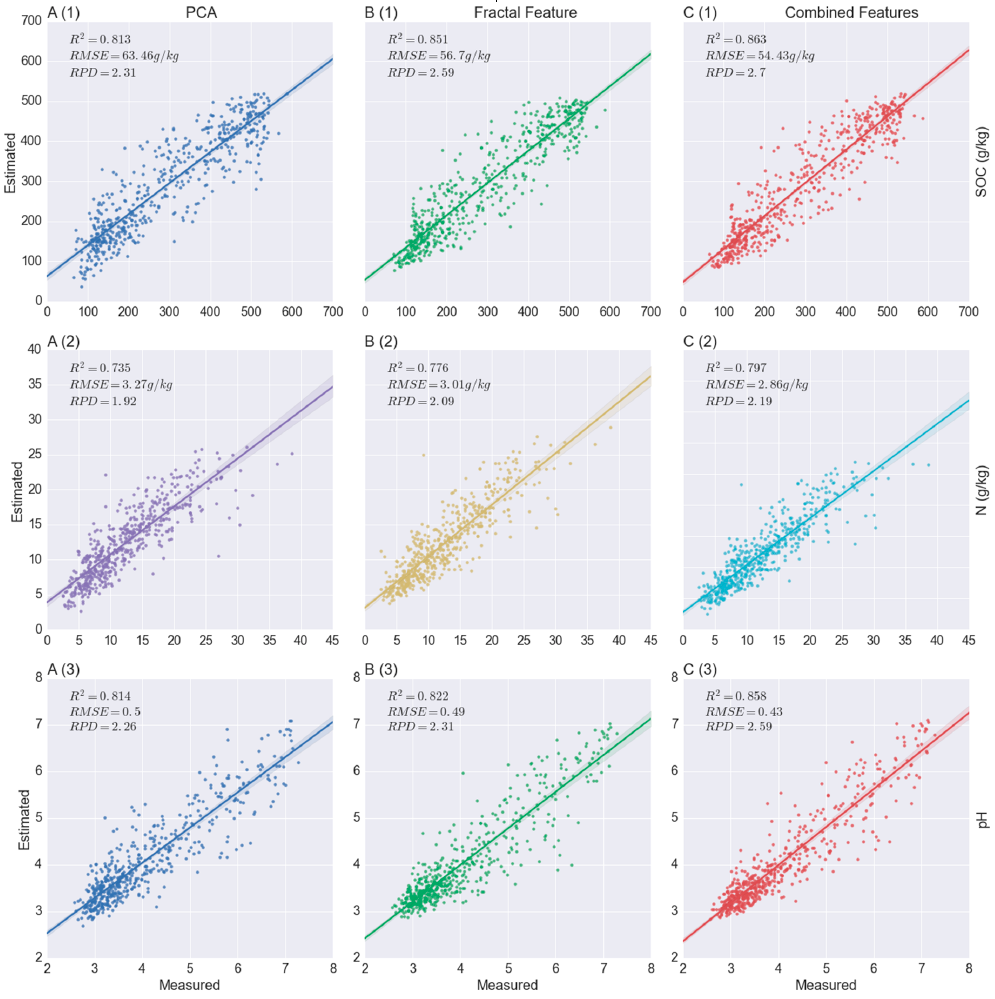
Figure 7. Best performance of gradient-boosting regression modelling accuracies for SOC, N and pH. ( A1 ), ( A2 ) and ( A3 ) were with PCA-transformed features. ( B1 ), ( B2 ) and ( B3 ) were with fractal features. ( C1 ), ( C2 ) and ( C3 ) were with features combined by PCA-transformed features and fractal features. R 2 : coefficient of determination; RMSE: root mean square error; RPD: the ratio of percent deviation.